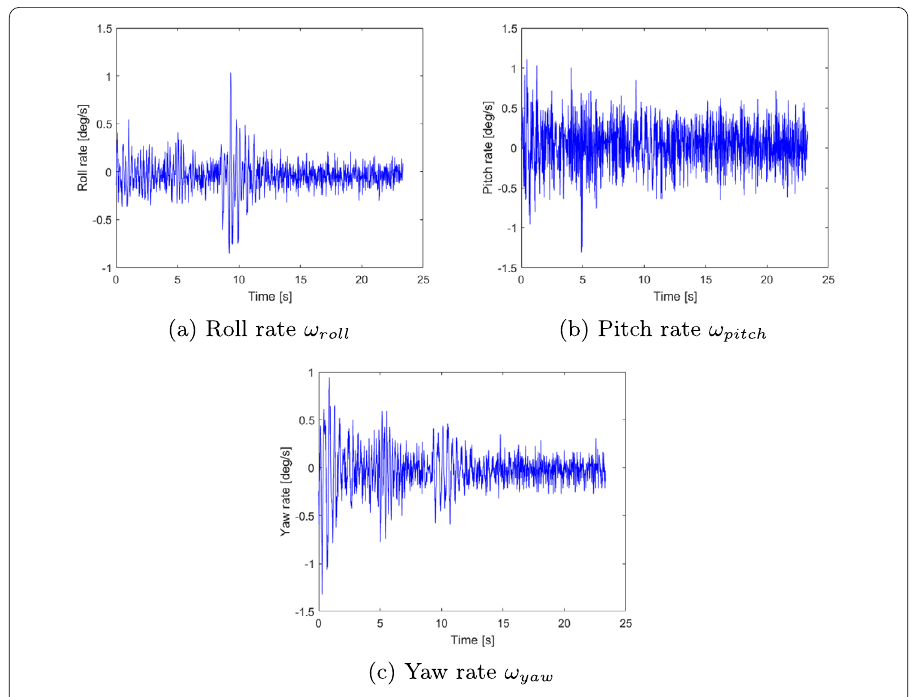
Figure 6 Raw angular velocity data for roll, pitch and yaw axes of link L